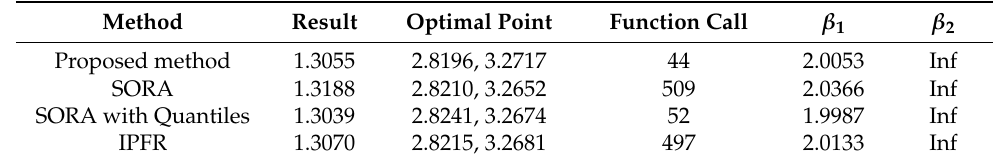
Table 3. Comparison results summary of the Haupt